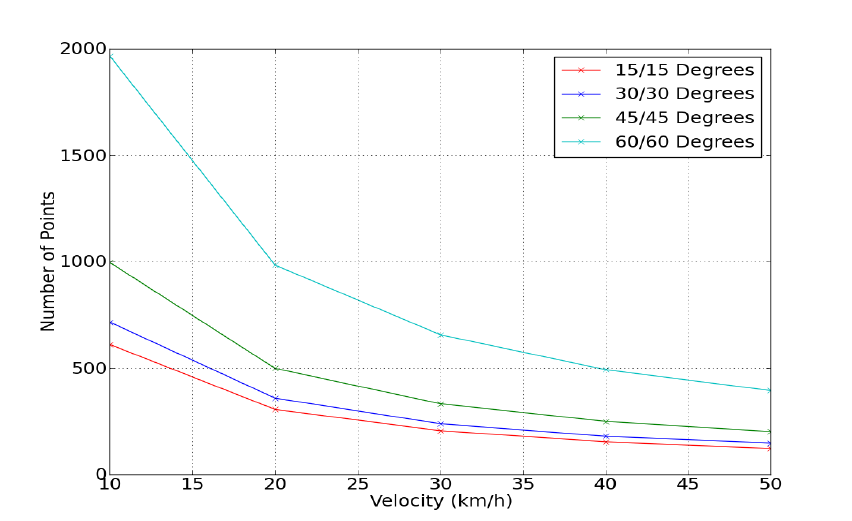
Figure 6. The effect of vehicle velocity and dual axis scanner rotation on the number of points for a narrow vertical target. Target range is 5 m and target dimensions are 0.1 m × 2